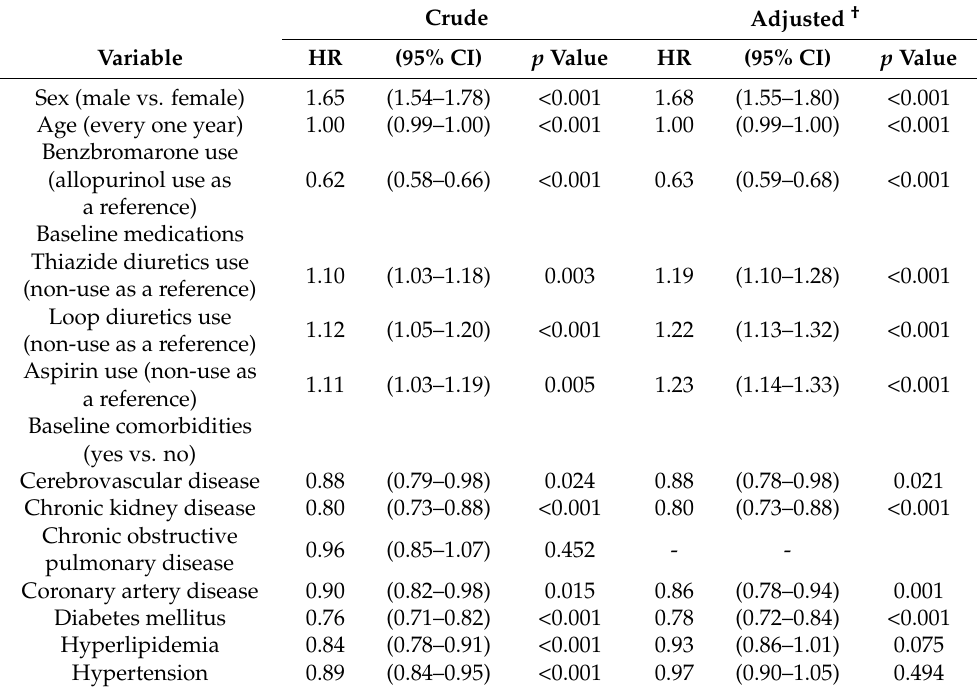
Table 3. Hazard ratio and 95% confidence interval of the first gout flare associated with medications and comorbidities.